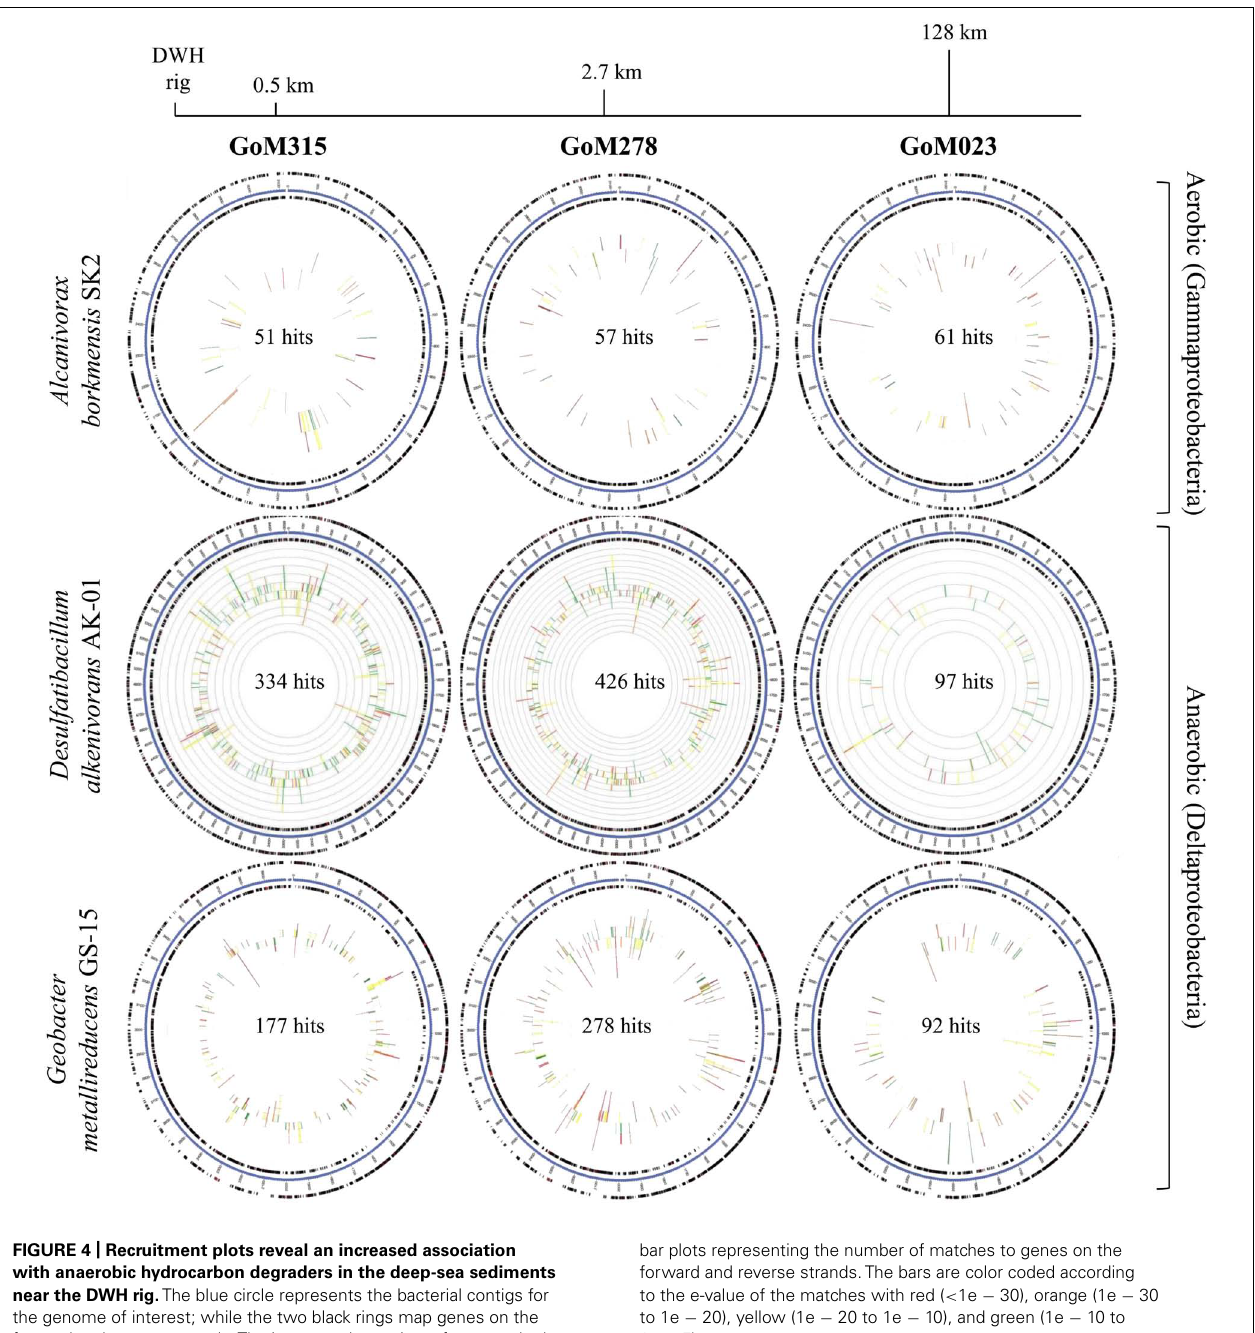
bar plots representing the number of matches to genes on the forward and reverse strands.The bars are color coded according to the e-value of the matches with red ( < 1e − 30), orange (1e − 30 to 1e − 20), yellow (1e − 20 to 1e − 10), and green (1e − 10 to 1e −